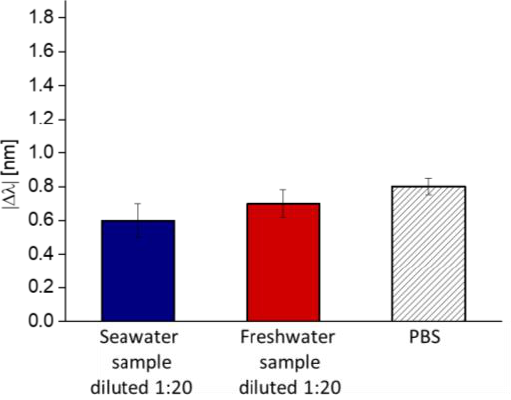
Figure 7. The absolute value of resonance wavelength variation (with respect to the blank) for different matrices with the theoretical addition of estradiol (20 pM). The samples were diluted 1:20 before testing. The error bars were calculated as the standard deviation of the dataset (n = 3).